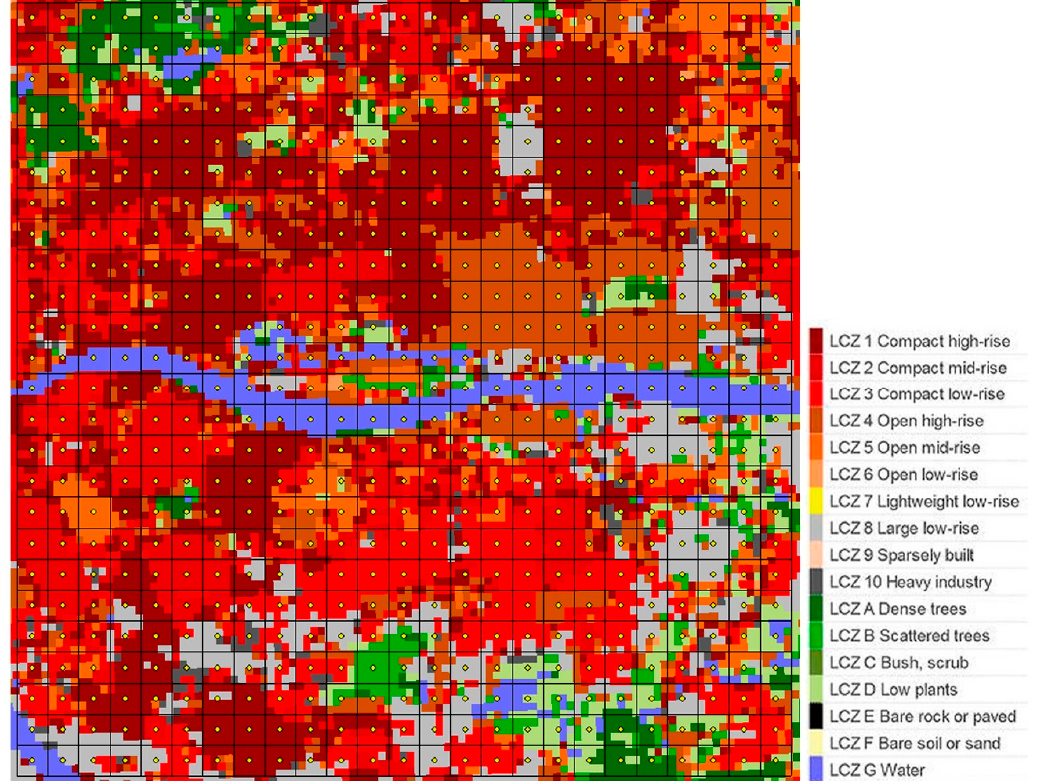
Figure 3. LCZ classification map with grids of 400 m × 400 m for the central urbanized area of Guangzhou.